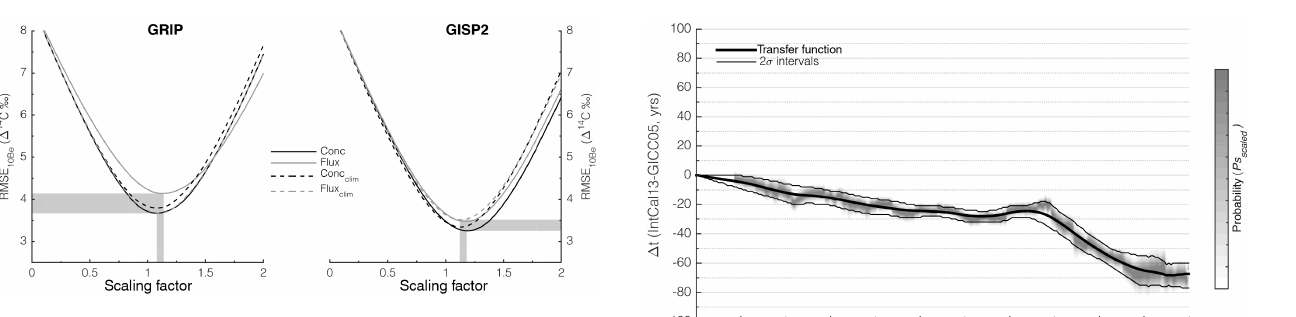
Figure 8. Rooted mean square error (RMSE 10 Be ) of IntCal13 (cid:49) 14 C and 10 Be based (cid:49) 14 C records from GRIP (left) and GISP2 (right) for different scalings of the 10 Be based data after synchro- nization. The RMSE 10 has been calculated for binned data (bin Be size = 2.5‰, see text) taking IntCal (cid:49) 14 C errors into account.